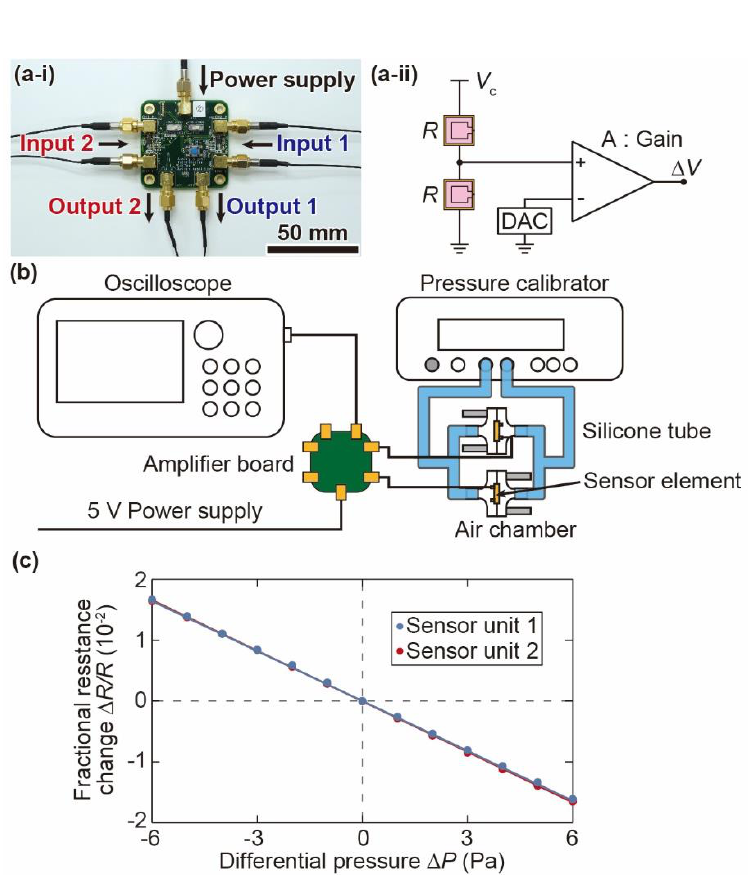
Figure 7. Differential pressure calibration of the sensor chip. ( a-i ) Photograph of the amplifier board used for the angular acceleration sensor. ( a-ii ) Schematic illustration of the bridge amplifier circuit. ( b ) Schematic image of the experimental setup, and ( c ) relationship between the applied differential pressure and the fractional resistance changes in the piezoresistive cantilevers.